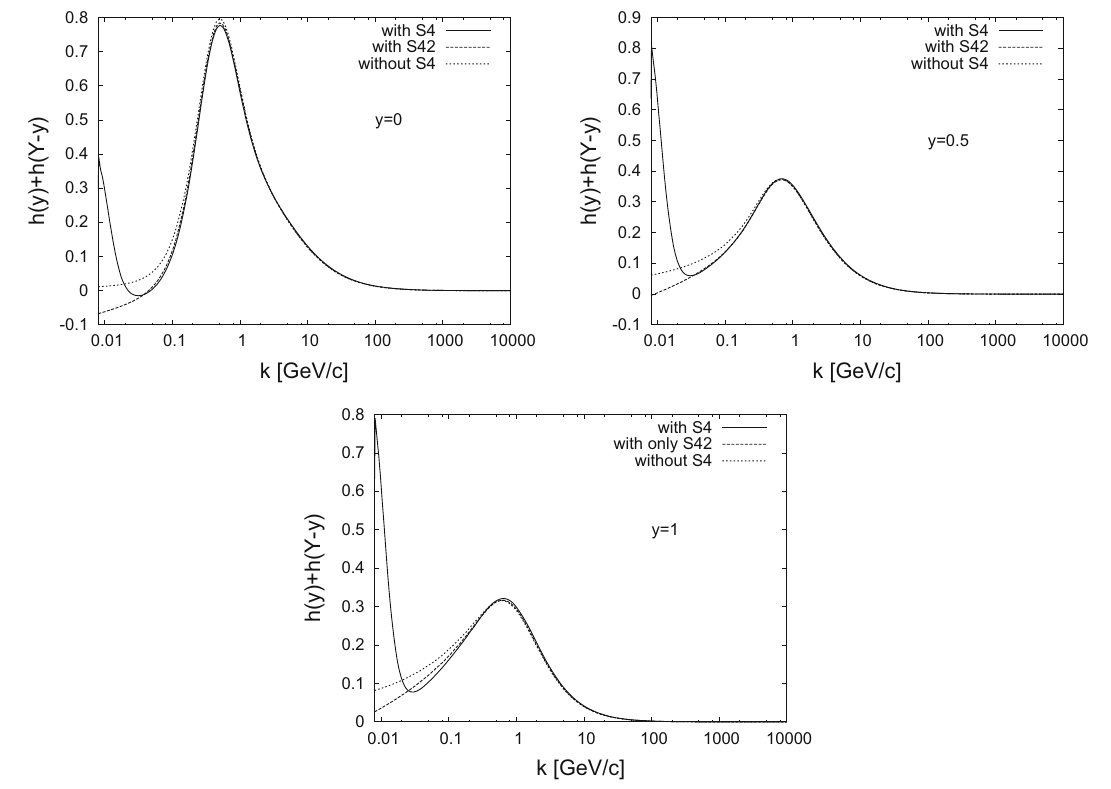
+ S ( 2 ) at intermediate 4 4